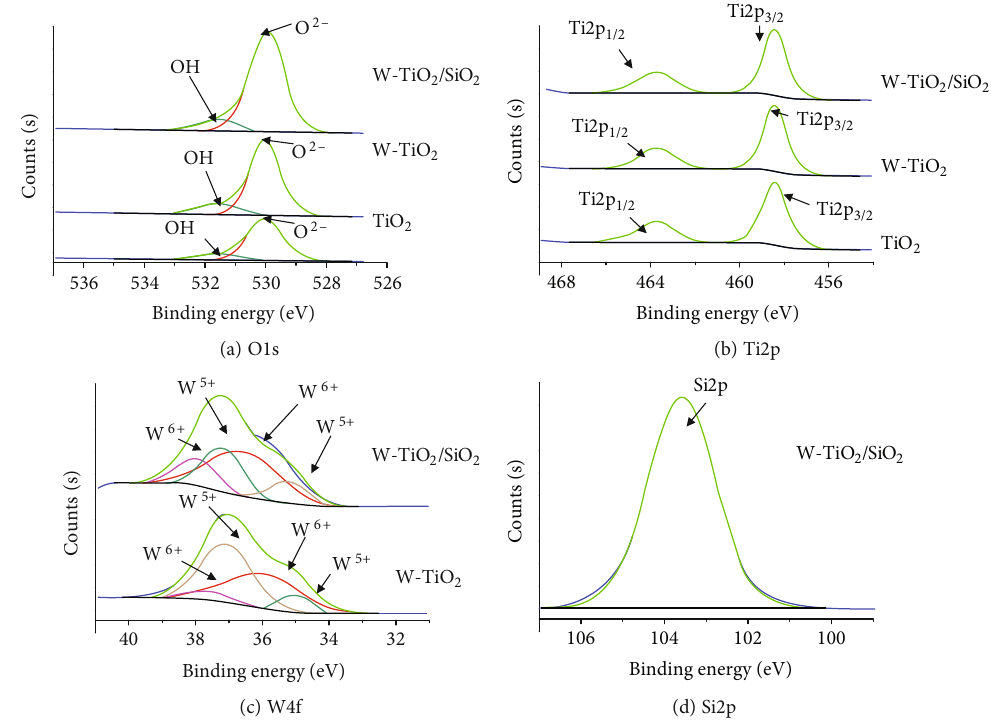
Figure 6: XPS spectra of the TiO